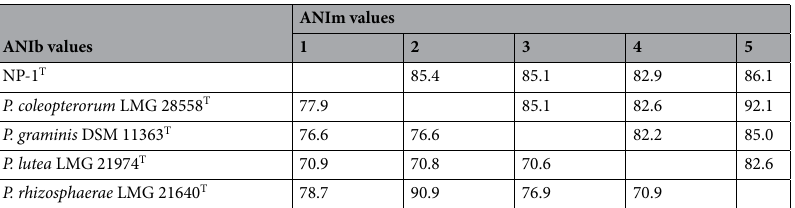
Table 1. Average nucleotide identity percentages based on BLAST (ANIb) and on MUMmer (ANIm) of Pseudomonas eucalypticola NP-1 T and type strains of closely related species of the genus Pseudomonas . Taxa indicated as: 1, Pseudomonas eucalypticola NP-1 T ; 2, P. coleopterorum LMG28558 T ; 3, P. graminis DSM11363 T ; 4, P. lutea LMG21974 T ; and 5, P. rhizosphaerae LMG21640 T .